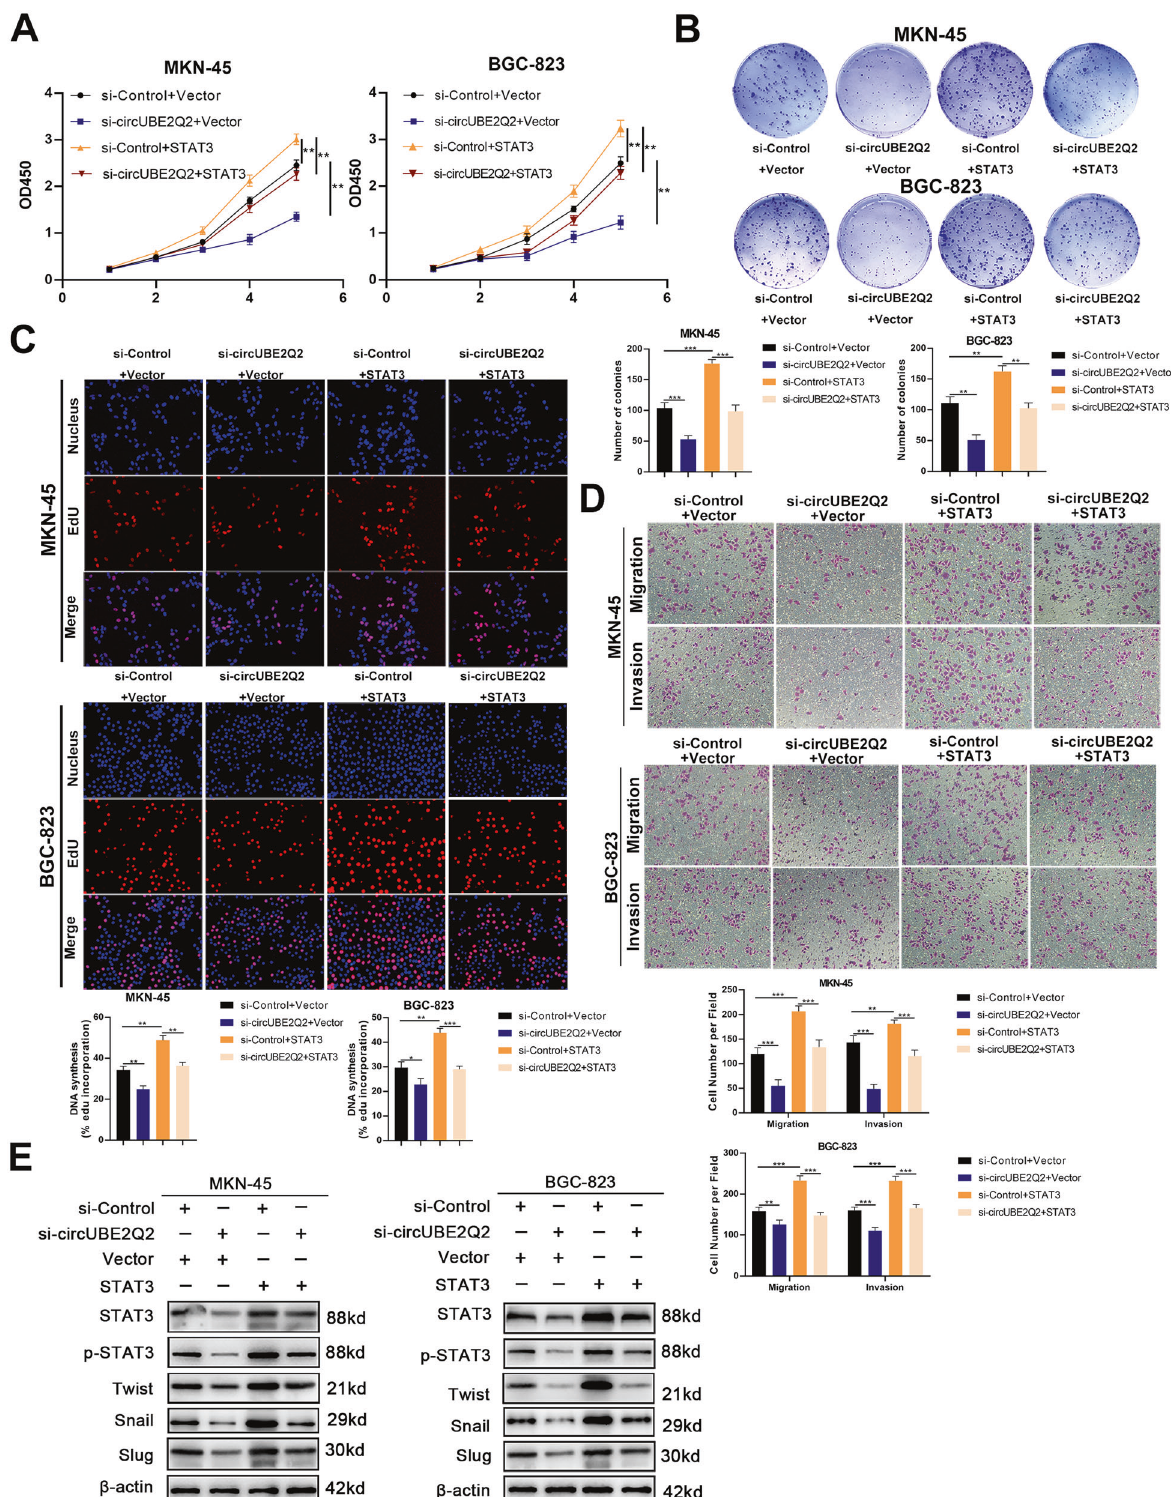
Fig. 5 STAT3 reverses the effects of circUBE2Q2 on GC. A CCK-8 analysis of the cell proliferation ability in MKN-45 and BGC-823 cell lines cotransfected with circUBE2Q2-speci fi c siRNA or STAT3 plasmids. B Colony formation assay of the cell proliferation ability in cotransfected MKN-45 and BGC-823 cell lines. C EdU analysis of the cell proliferation ability in treated MKN-45 and BGC-823 cell lines. D Transwell invasion and migration assay in treated MKN-45 and BGC-823 cell lines. E Western blot analysis of STAT3, p-STAT3, Twist, Snail, and Slug with proteins treated with circUBE2Q2-speci fi c siRNA or STAT3 plasmids in MKN-45 and BGC-823 cell lines. Data are expressed as the mean ± SD. * p < 0.05, ** p < 0.01, *** p < 0.001. Cell Death and Disease (2021)